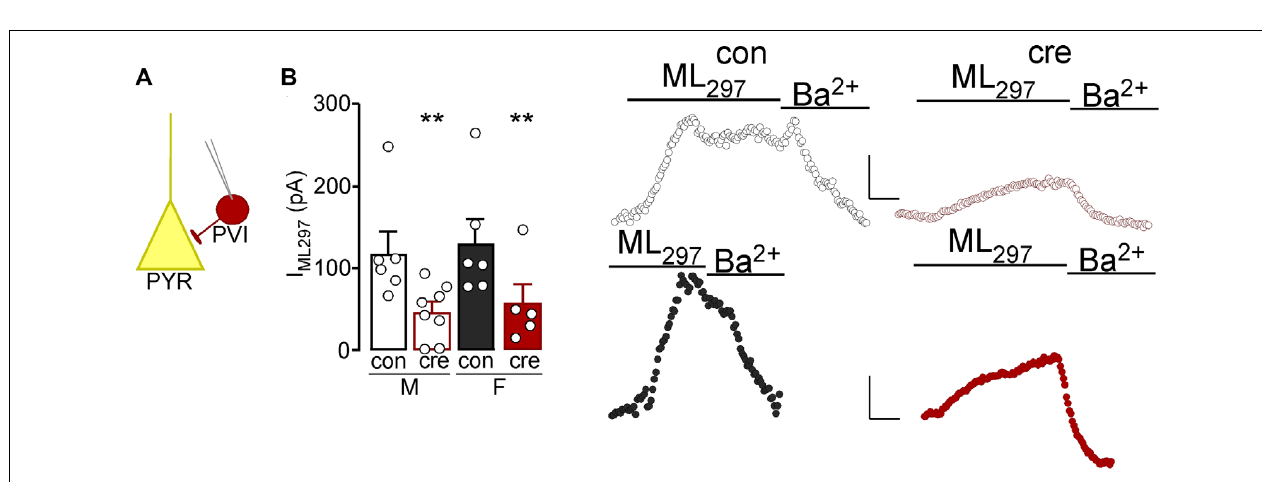
FIGURE 5 | (A) Whole-cell slice electrophysiology was used to record from parvalbumin interneurons (PVI) labeled with td-tomato in the prelimbic cortex. (B) The current induced by bath application of ML297 was lower in PVI from cre-positive mice (right representatives) compared to those from control mice (left representatives; ** p < 0.01). Scale bar: 50 pA/180